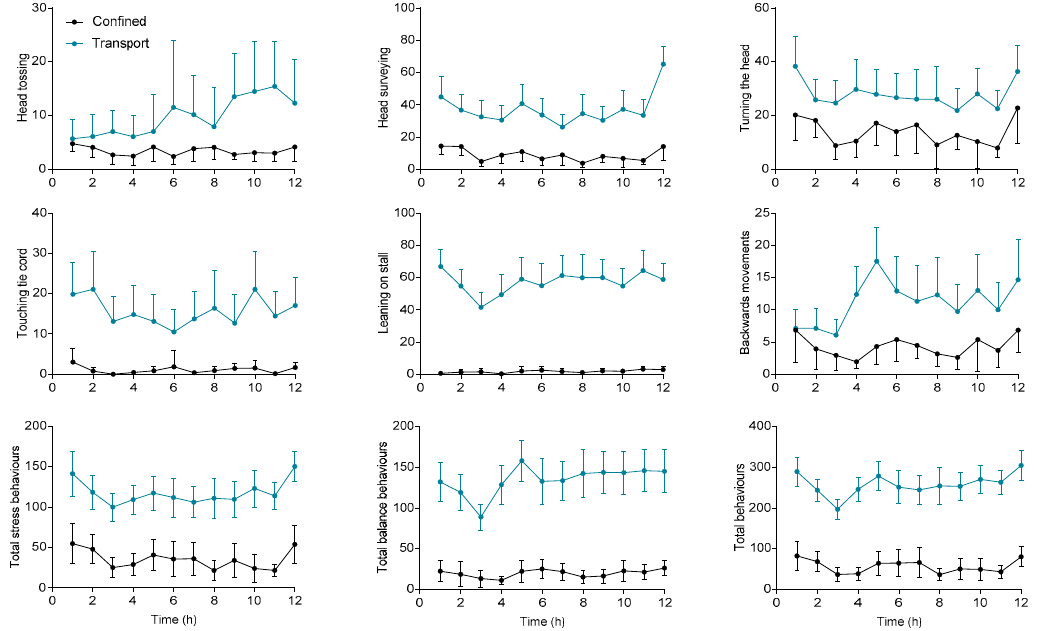
Figure 3. Frequency (n / 20 min) of key behavioural parameters during the 12 h of transportation (blue) and confinement (black). Results are shown as mean and standard error.